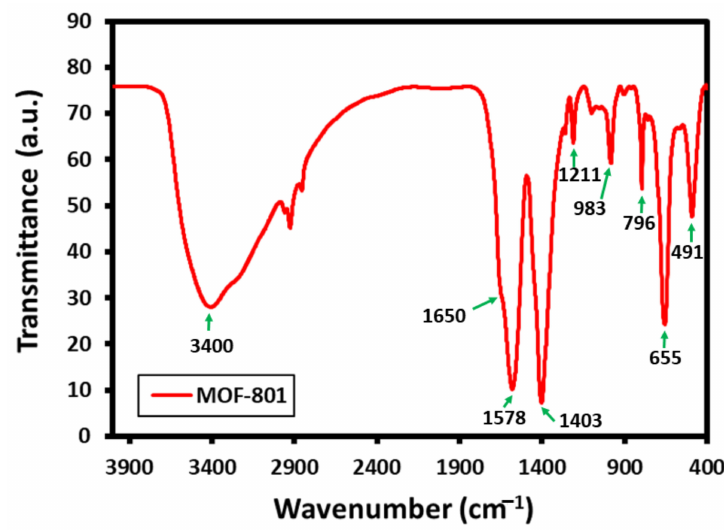
Figure 2. FT-IR analysis of MOF-801.